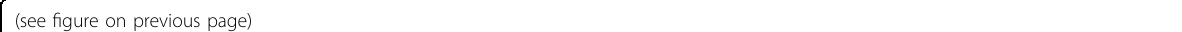
Fig. 3 Ketamine-induced c-fos brain expression in male WT and GluN2CKO mice. c-fos mRNA expression for male ( ♂ ) WT and GluN2CKO mice after saline or ketamine (30 mg/kg) administration. Upper, intermediate, and deep layers of primary and secondary motor cortices (upper M1 – M2, mid M1 – M2, and deep M1 – M2, AP: + 2.10), medial prefrontal cortex (mPFC, AP: + 2.10), cingulate cortex (Cg, AP: + 1.18), caudate-putamen